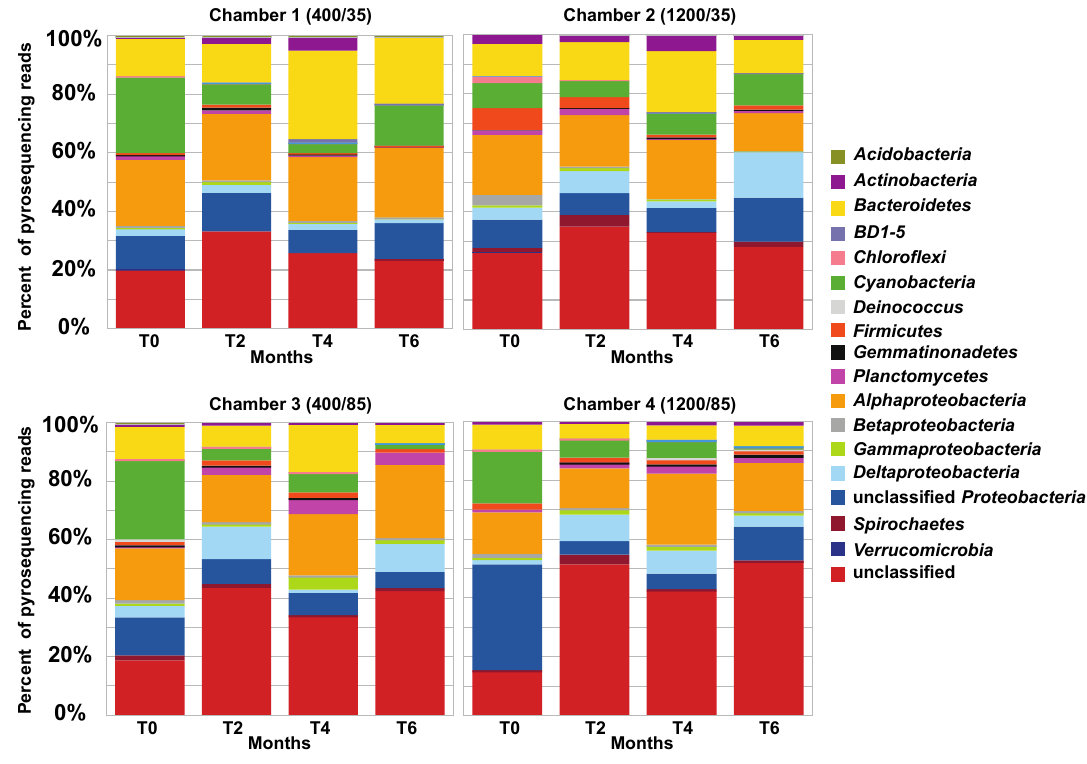
Figure 2. Comparison of taxonomic diversity based on operational taxonomic units (OTUs) within the four treatments at 0 (T0), 2 (T2), 4 (T4) and 6 (T6) months. Histograms reflect the relative abundance as the percent of total sequences clustered into specific bacterial phyla, or sub-phyla, using a Bayesian approach at a confidence interval of ≥ 70%. The parameters within each environmental chamber are listed in parentheses and include the CO and salinity levels, 2